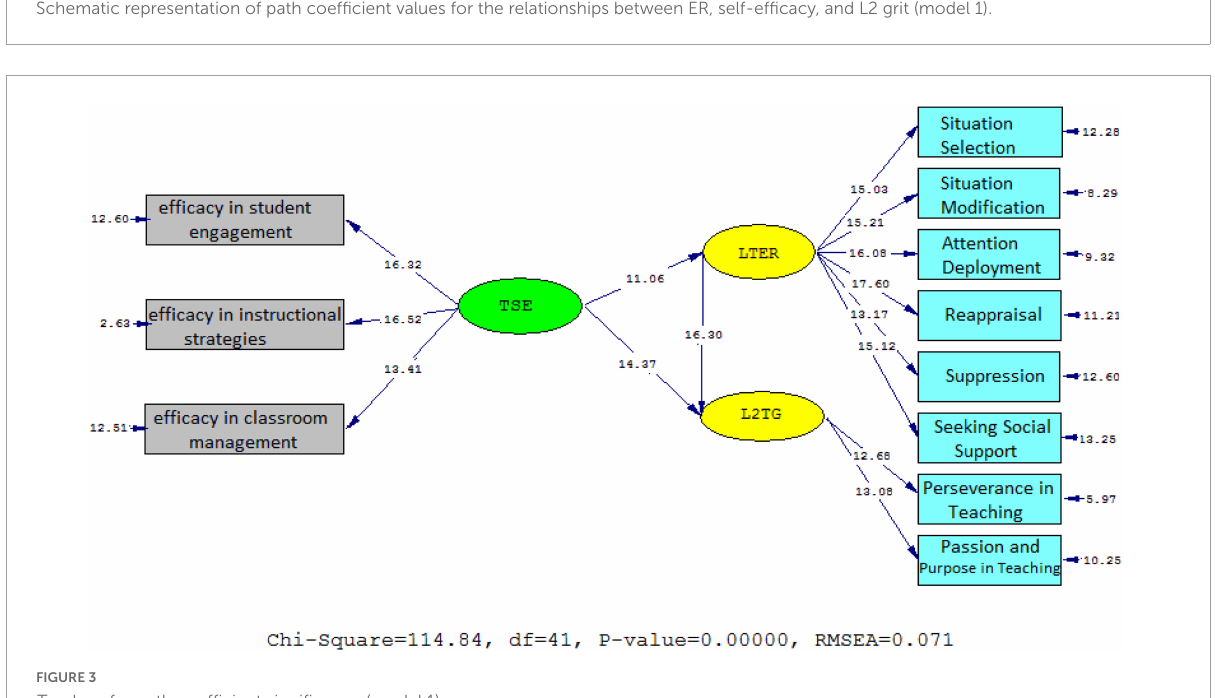
FIGURE2 Schematic representation of path coefficient values for the relationships between ER, self-efficacy, and L2 grit (model 1).